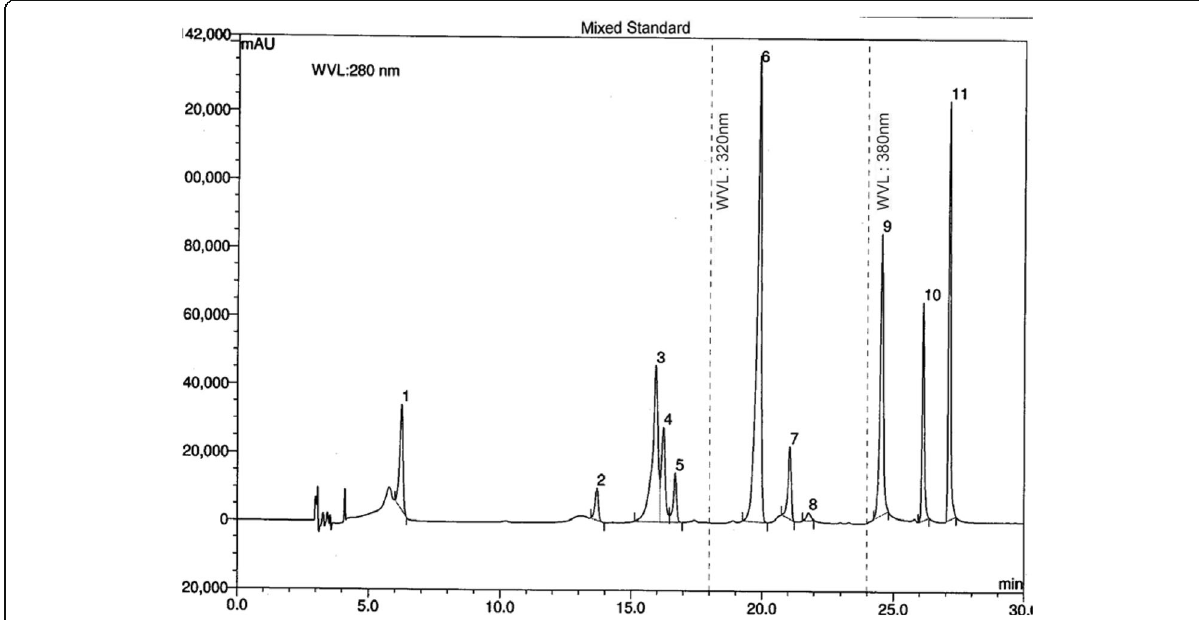
Fig. 1 HPLC chromatogram of a standard mixture of polyphenolic compounds (peak 1: gallicacid, 2:(+)-catechin, 3:vanillic acid 4: caffeic acid 5: